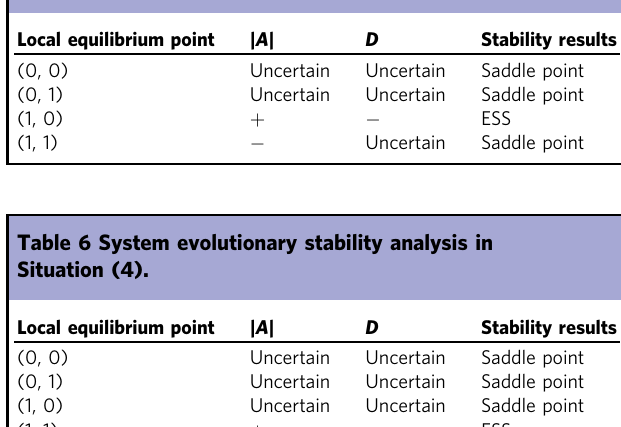
Table 5 System evolutionary stability analysis in Situation (3).